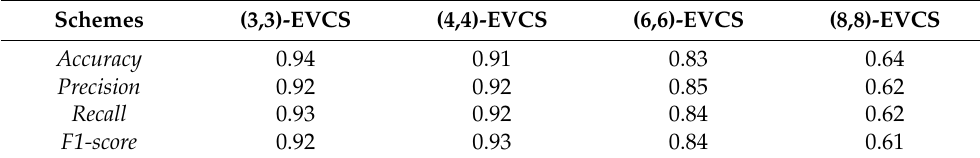
Table 3. Comparisons of the recognition performance for different numbers of images shared in the RSSCN7